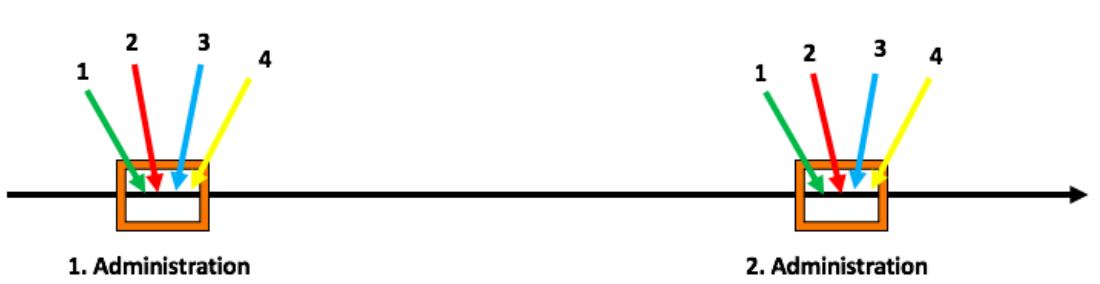
Figure 1. A four-step approach for optimal administration of cell-depleting anti-ICPM compounds. The figure depicts four steps that are proposed for the optimal administration of a cell-depleting anti-ICPM compound allowing to achieve the depletion of a maximum number of ICPM-expressing tumor cells. Abbreviations: ICI, immune checkpoint inhibitor; ICPM, immune checkpoint molecule.